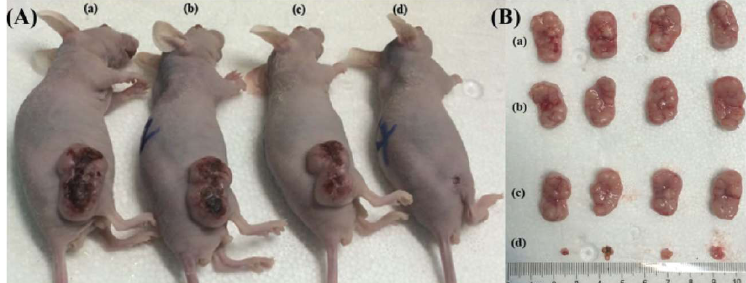
Figure 8. ( A ) Human oral epidermoid carcinoma (KB) tumor-bearing nude mice and ( B ) excised KB tumor images after 14 days of treatment with ( a ) phosphate-buffered saline (PBS), ( b ) α-CD-ss-Ce6 NPs without laser, ( c ) free Ce6 with laser, and ( d ) α-CD-ss-Ce6 NPs with laser. Reproduced from Reference [42] with permission from Small , 2016.